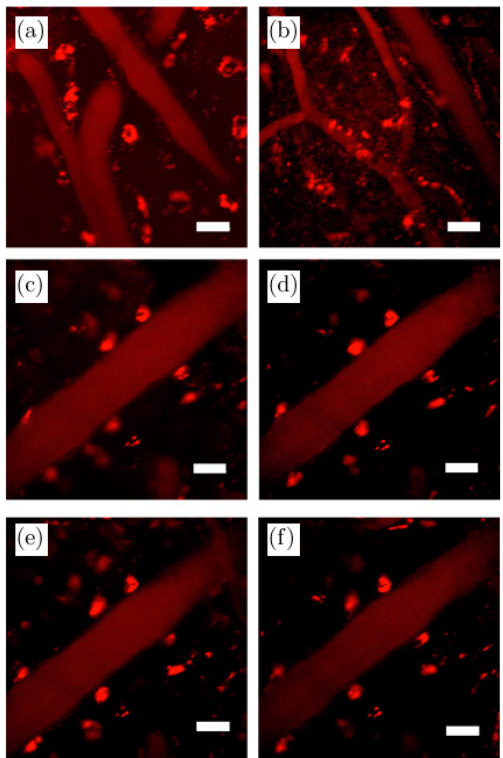
Fig. 7. 2PM images of balb/c mice's brain vessels with (a – b) di®erent visual ¯elds, taken with 800 nm two-photon excita- tion, the scale bar stands for 20 (cid:4) m. (c – f) Focus on single brain vessel at varied time points of 1/5/10/15min after post injection (p.